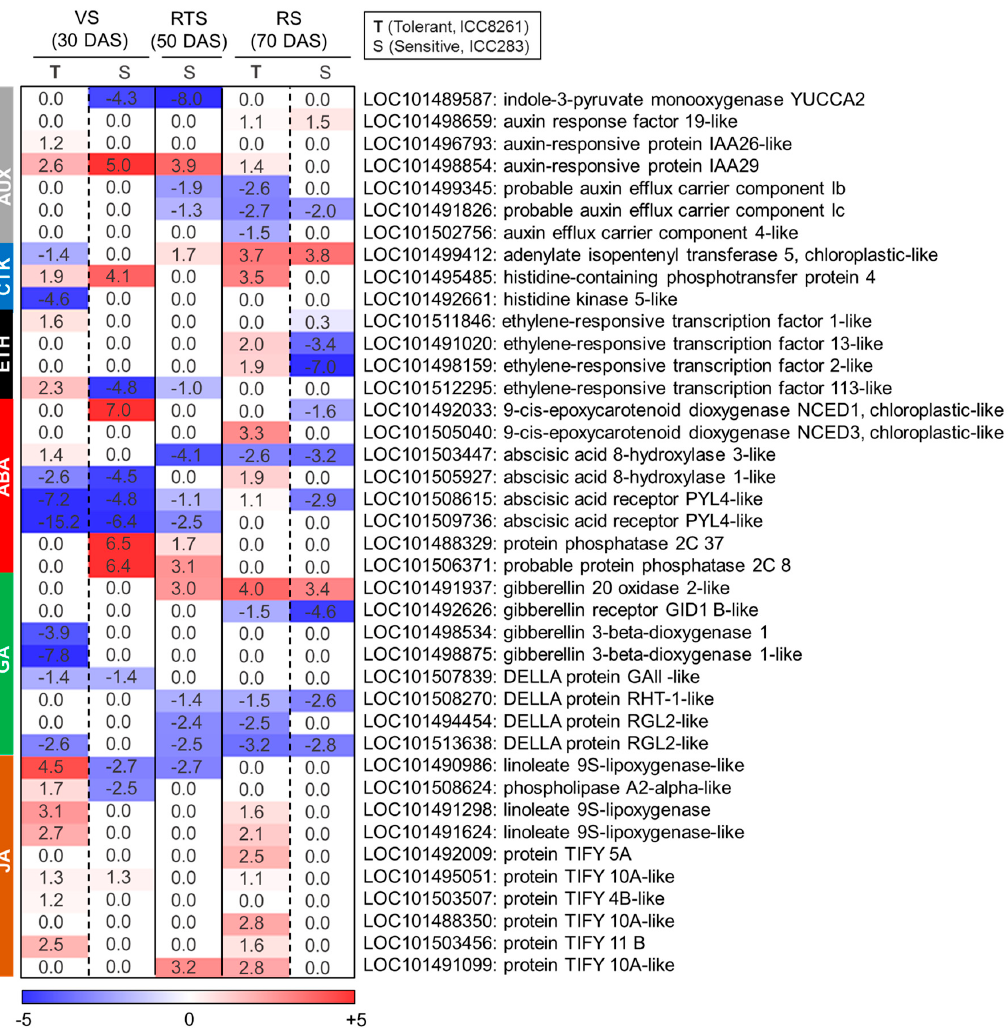
Figure 7. Heatmap illustrating differential regulation of auxin (AUX), cytokinin (CK), ethylene (ETH), abscisic acid (ABA), gibberellic acid (GA)and jasmonic acid (JA) related genes in the tolerant (T, ICC8261) and sensitive genotype (S, ICC283) at vegetative (VS), reproductive transition (RTS) and reproductive (RS) stages. The scale color represents log2 fold change.